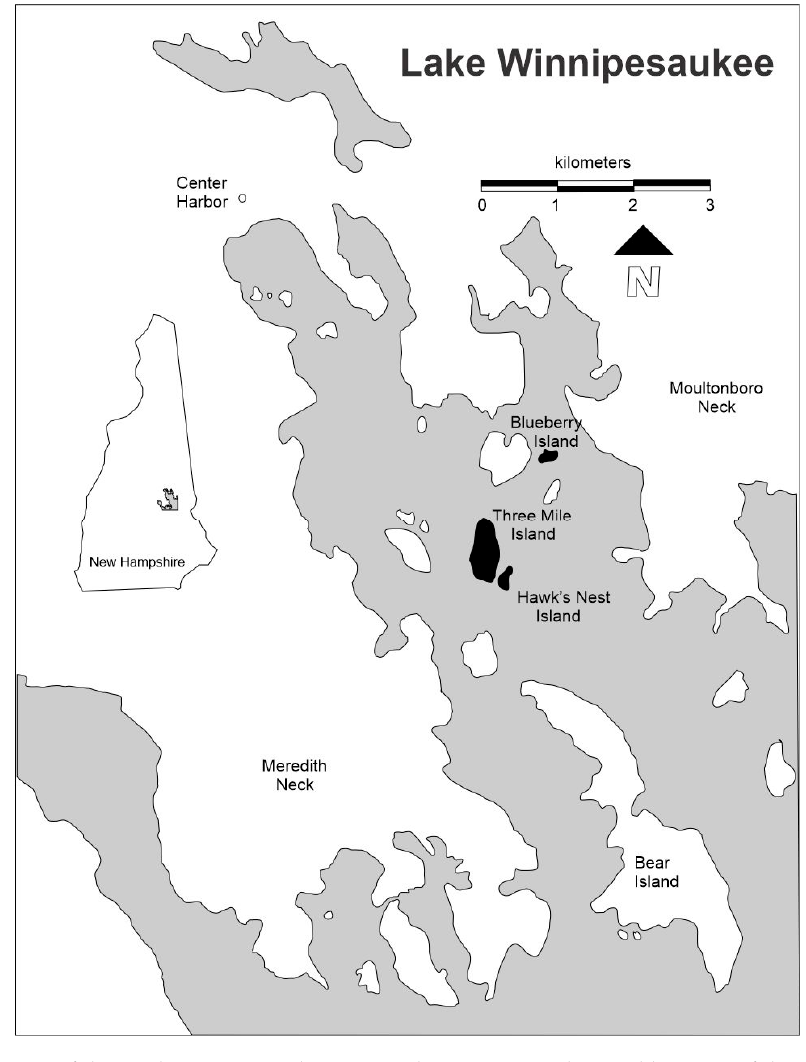
Figure 1. Map of the study area in northeastern Lake Winnipesaukee and location of the study sites (shown in black-shading) in New Hampshire, USA. [3].